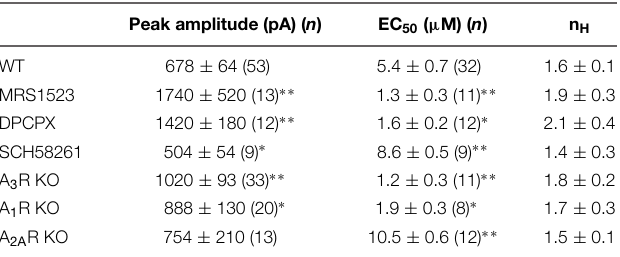
Data represent means ± SEM (number of cells) of: Column 2, mean Peak amplitude response to a test dose of agonist (AMPA 10 μ M); Column 3, 4 fit parameters for dose-response curve fitted by Hill equation. ∗ p < 0.05 and ∗∗ p < 0.01, significantly different from control value in WT untreated neurons, as specified in Column